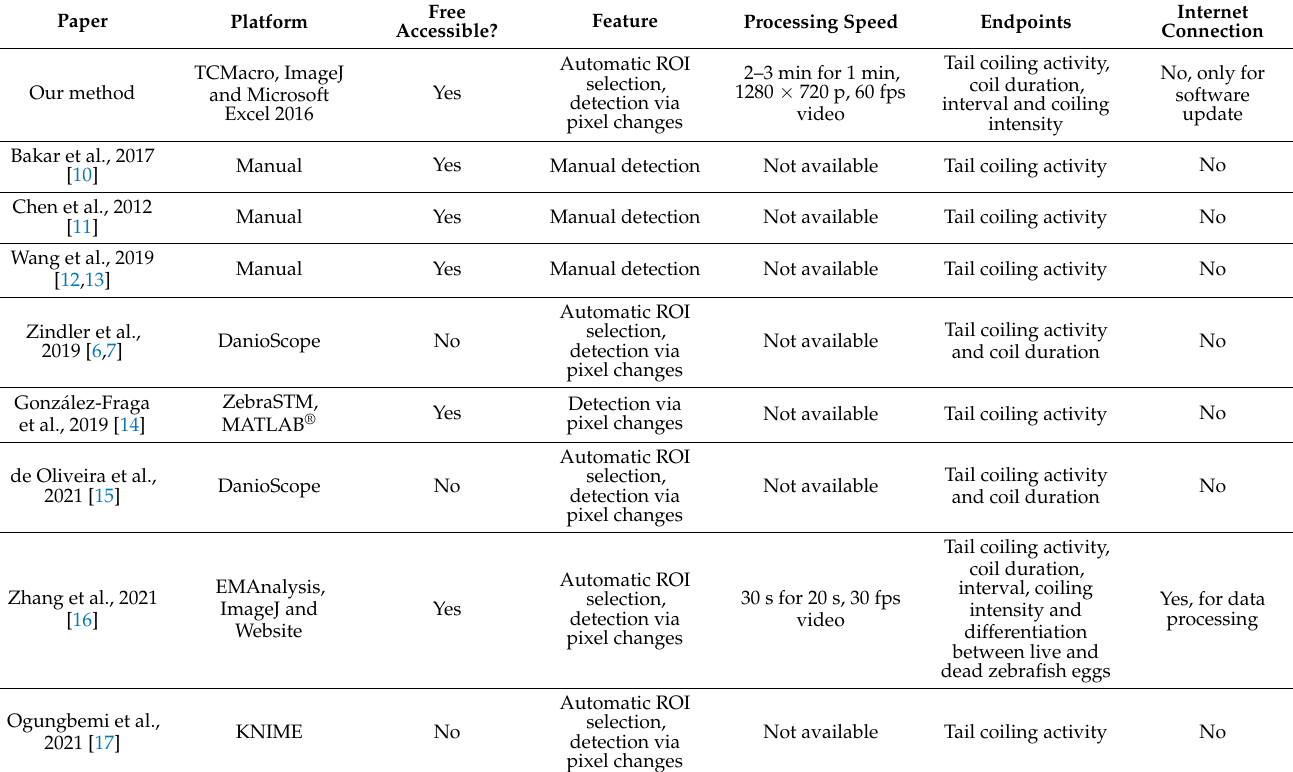
Table 1. Comparison of available methods for obtaining tail coiling activity in